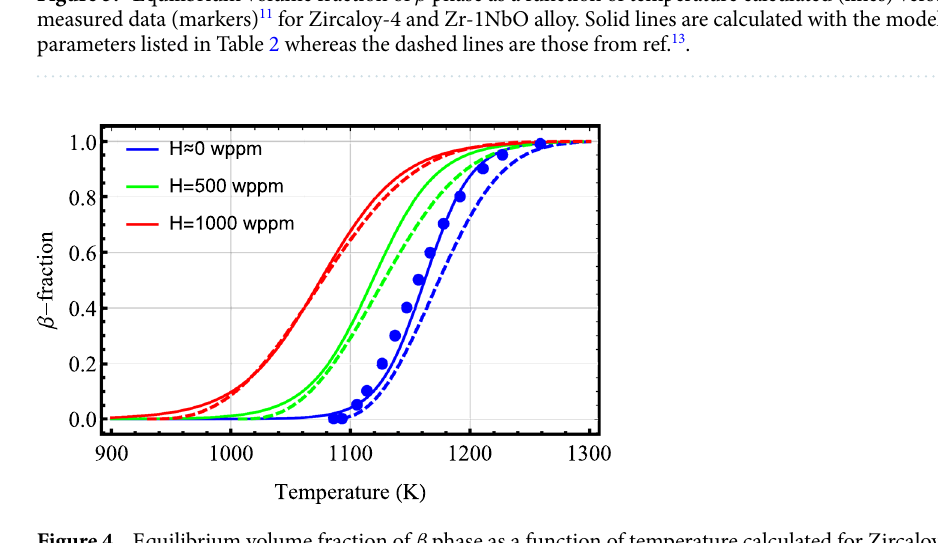
Figure 4. Equilibrium volume fraction of β phase as a function of temperature calculated for Zircaloy-4 with several concentrations of hydrogen. Solid lines are calculated with model parameters listed in Table 2 whereas the dashed lines are those extracted from figure 12 of ref. 20 , which are based on analysis of experimental data. 0 wppm from ref. 11 The disks show measured data for H ≈